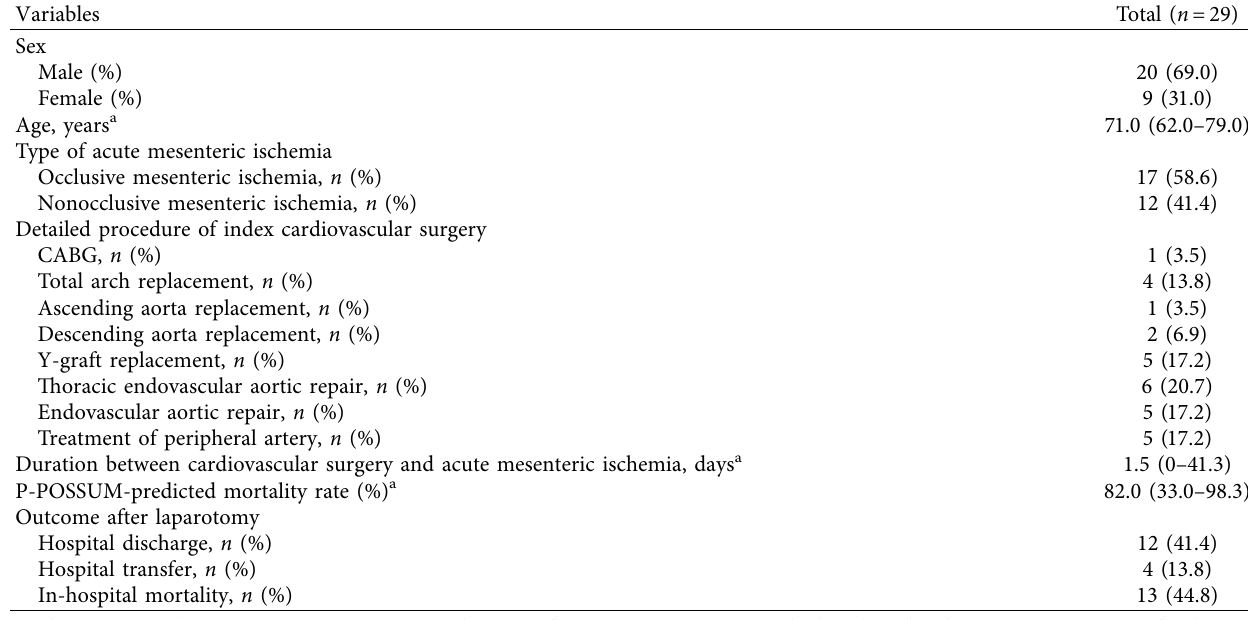
Table 1: Patient characteristics.